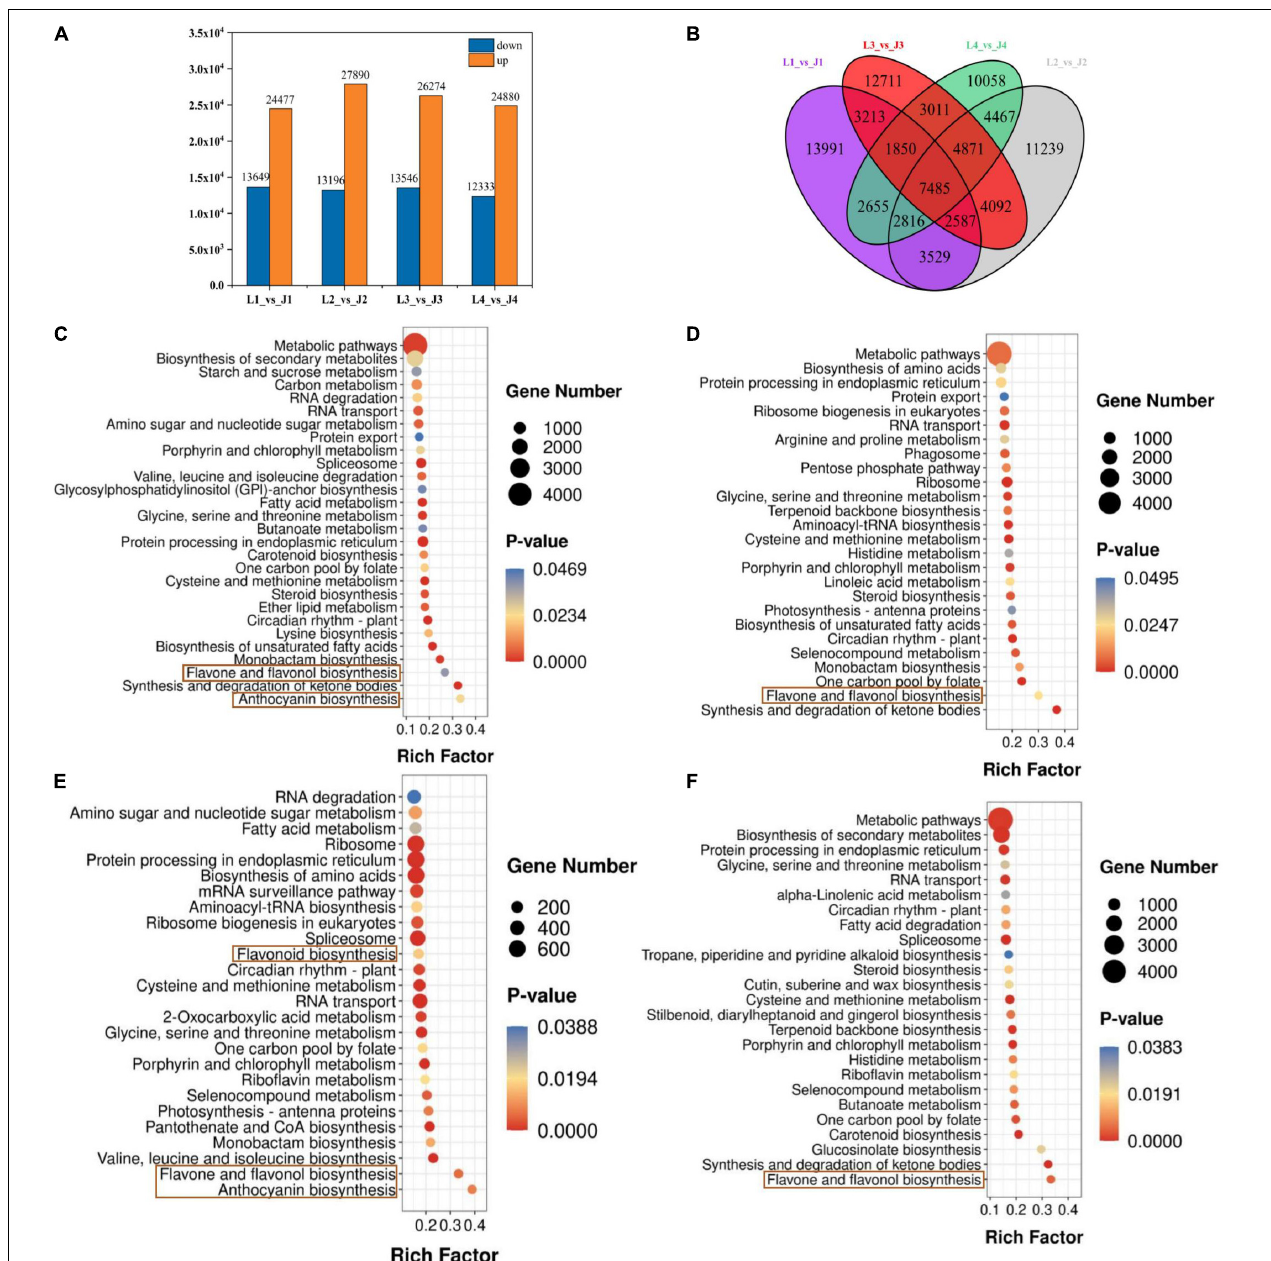
FIGURE 2 | Differentially expressed genes (DEGs) in LS and JS. (A) Statistics of DEGs in different comparison groups of LS and JS. Red indicates upregulated DEGs. Green indicates downregulated DEGs. (B) Venn diagram of DEGs. (C–F) DEGs enrichment KEGG scatter plot in four stages of LS and JS comparison groups. (C) L1 vs. J1 group. (D) L2 vs. J2 group. (E) L3 vs. J3 group. (F) L4 vs. J4